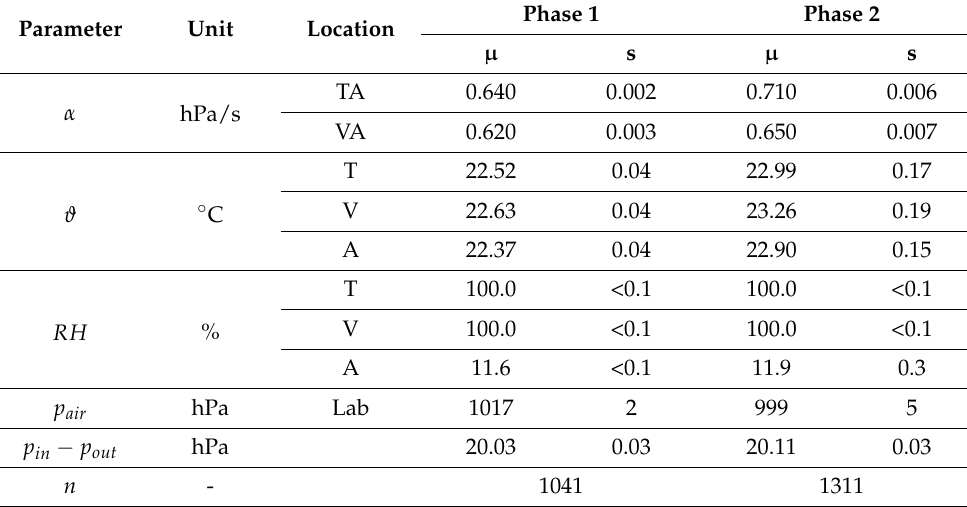
Table A1. Means ( µ ) and standard deviations (s) for Experiment